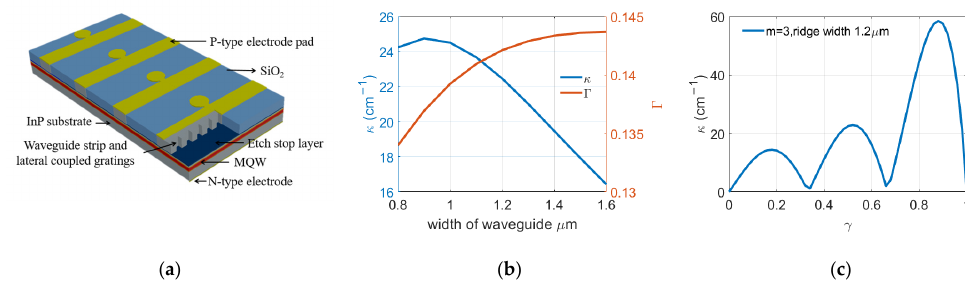
Figure 1. ( a ) Schematic of the structure of the laterally coupled distributed feedback (LC-DFB) laser array with deep and planar lateral gratings. ( b ) κ (blue line) and 𝛤 (red line) versus the ridge width with the third order gratings and a duty factor of 0.5. ( c ) κ as a function of the duty cycle γ on third order gratings with a ridge width of 1.2 μ m.